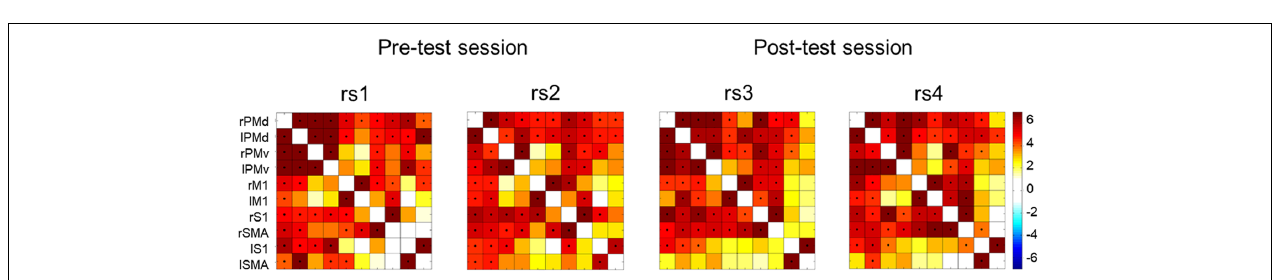
FIGURE 4 | Behavioral performance during the scan and training sessions for the N-ISO condition. There was an initial reduction in target deviation error during the pre-test session, indicative of initial learning. During the training period, BTT performance became more stable, particularly during the last two training days. YA showed a more stable performance during the post-test session than OA, especially in the most difficult task condition (N-ISO). Error bars represent the standard error of the mean (SEM). N-ISO, non-isofrequency.